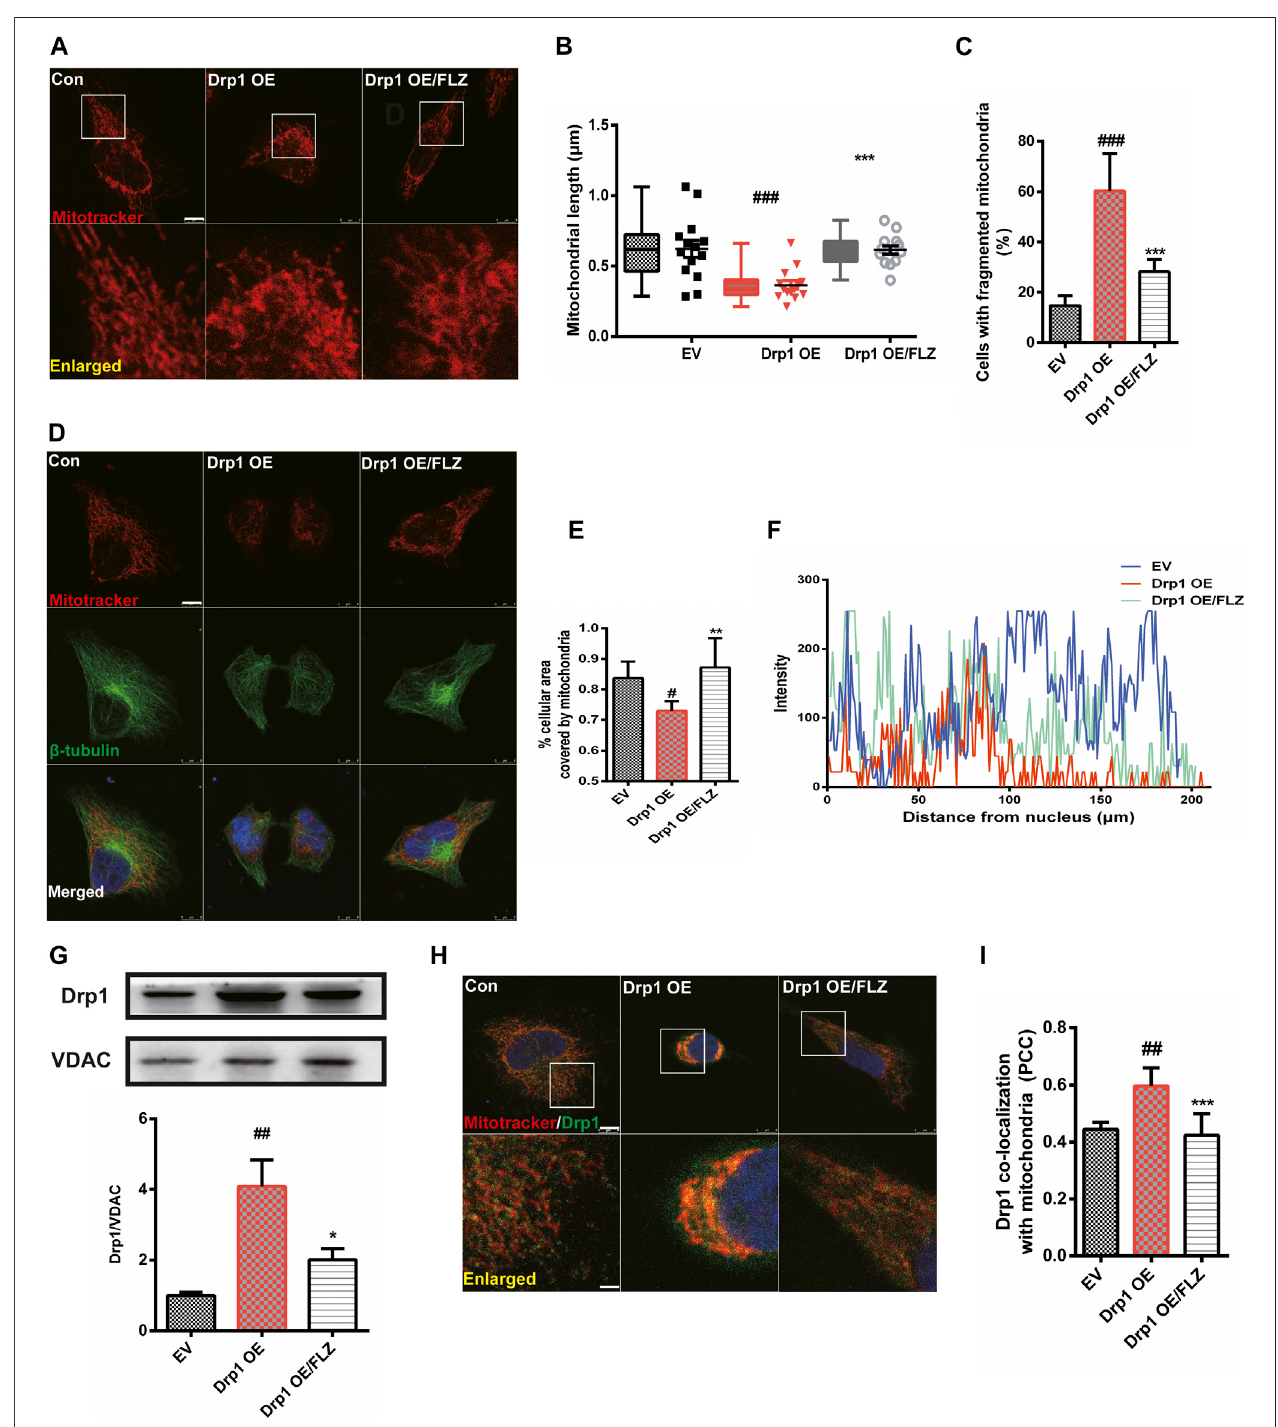
FIGURE 4 | FLZ treatment reduced mitochondrial fragmentation in Drp1 overexpressed cells. Cultured Hela cells were transfected with a plasmid encoded Drp1 protein for 24 h and then the cells were incubated with FLZ for 24 h (A) Mitochondrial morphology was analyzed by a confocal microscope. Cells were stained with mitotracker (red). Lower panels show enlarged areas of the white boxes in the above panels (Scale bar: up: 8 μ m. down: 2.5 μ m). (B) Average mitochondrial length measured by Image-pro Plus software. Data are presented as the means ± SEM from 4 independent experiments of 20 – 30 random selected cells (C) The percentage of cells with fragmented mitochondria relative to the total number of cells was counted by an observer blinded to the experimental conditions. At least 200 cells per group were counted. (D) Mitochondrial distribution was analyzed by a confocal microscope. Cells were stained with mitotracker (red), β -tubulin (green) and DAPI (blue) (scale bar: 8 μ m). (E) The percentage of cellular area covered by mitochondria